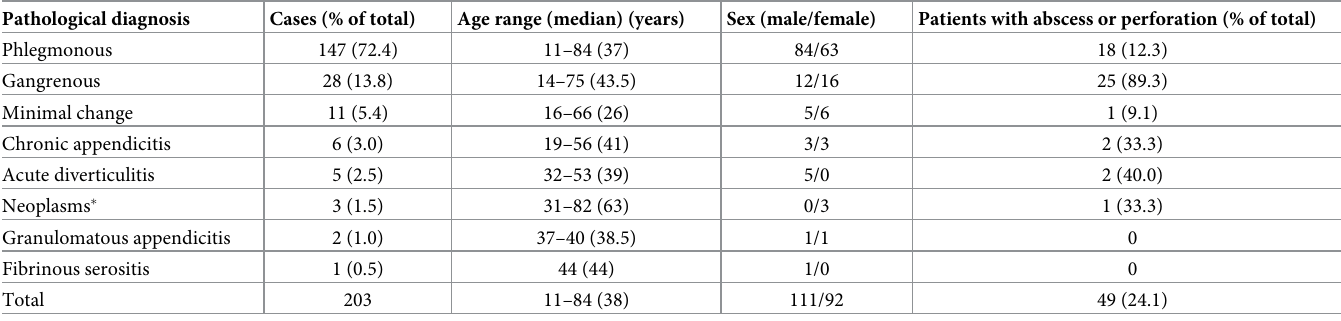
Table 1. The breakdown of the pathological diagnoses of 203